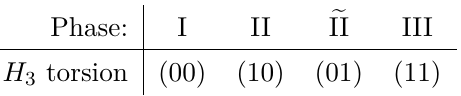
Figure 14. Partially flipping the q